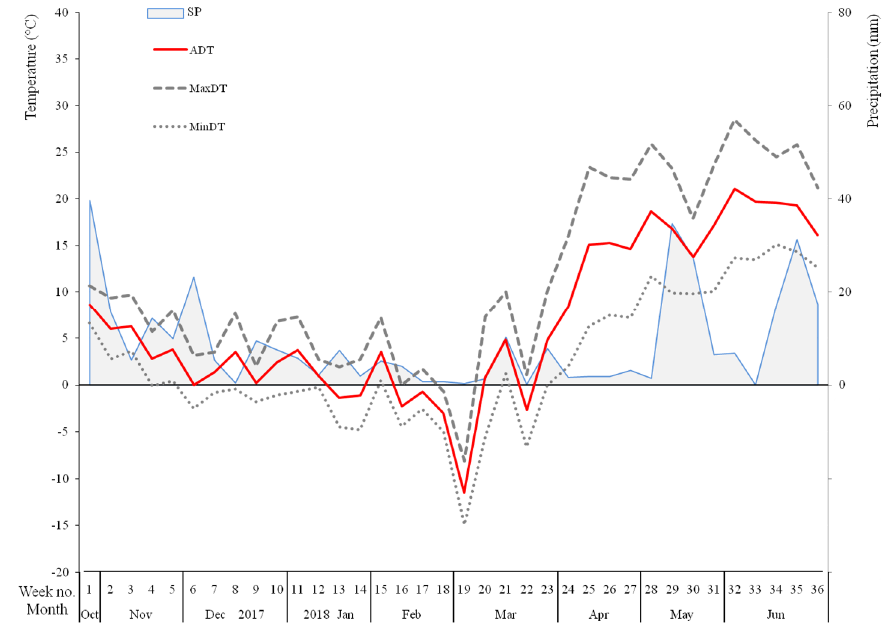
Figure 2. The characteristics of weather conditions during the experiment period in Krakow location.